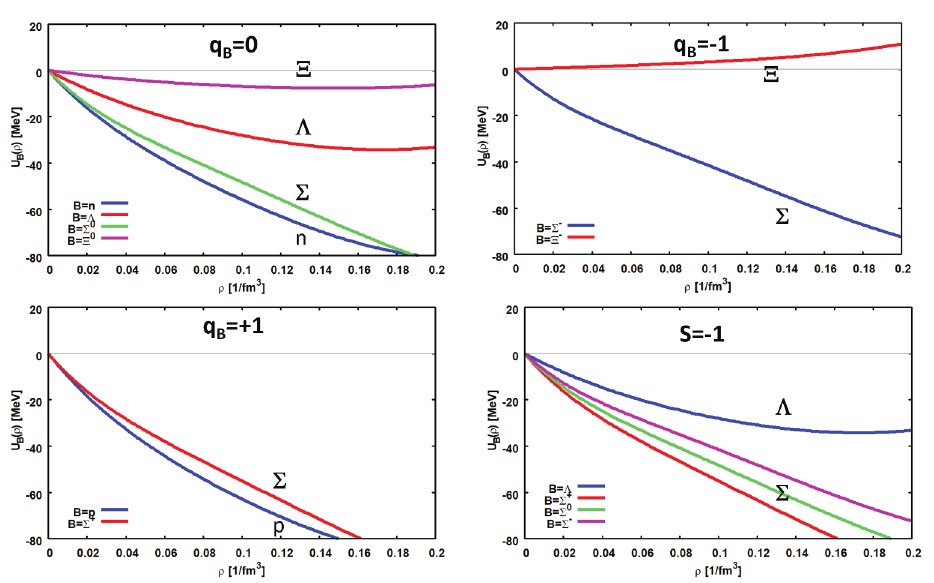
Figure 3. Baryon covariant mean– fi elds in in fi nite asymmetric matter are shown where U B ( ρ ) = U ( S ) ( ρ ) + U ( V ) ( ρ ) is the sum of scalar and vector potentials, including both isoscalar and isovector B B interactions. Results for Z / A = 0 . 4 are displayed, realized e.g. in 10 Be and approximately in 48 Ca, 124 Sn, and 208 Pb. Results are shown for baryons of equal charge (left and right top) and compared for the S = 1 multiplet of hypercharge Y = 0 consisting of the Σ iso–triplet and the Λ −